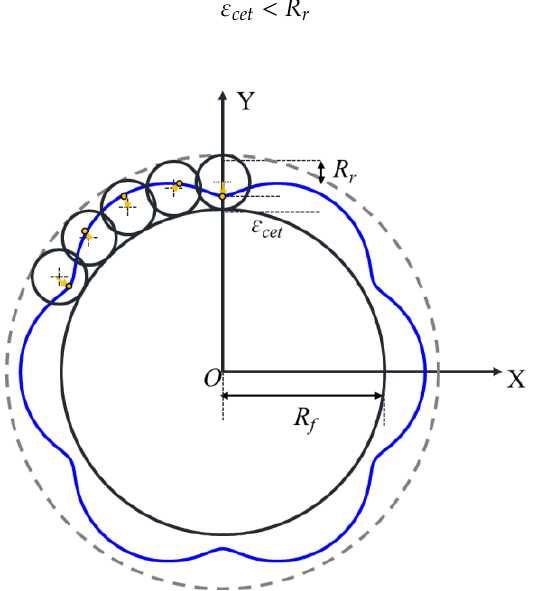
Figure 2. Curtate epitrochoid (CET) curve.